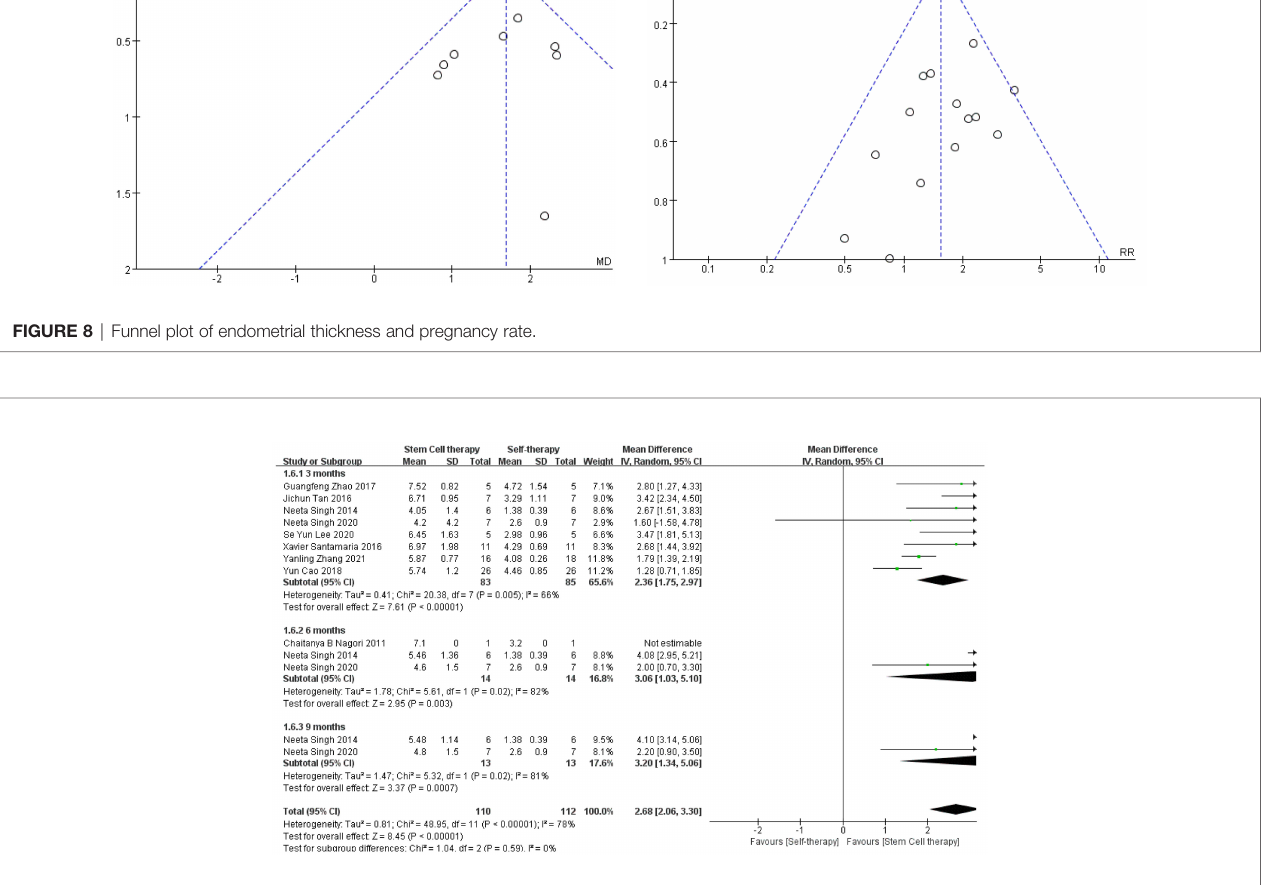
FIGURE 9 | Subgroup analysis of endometrial thickness